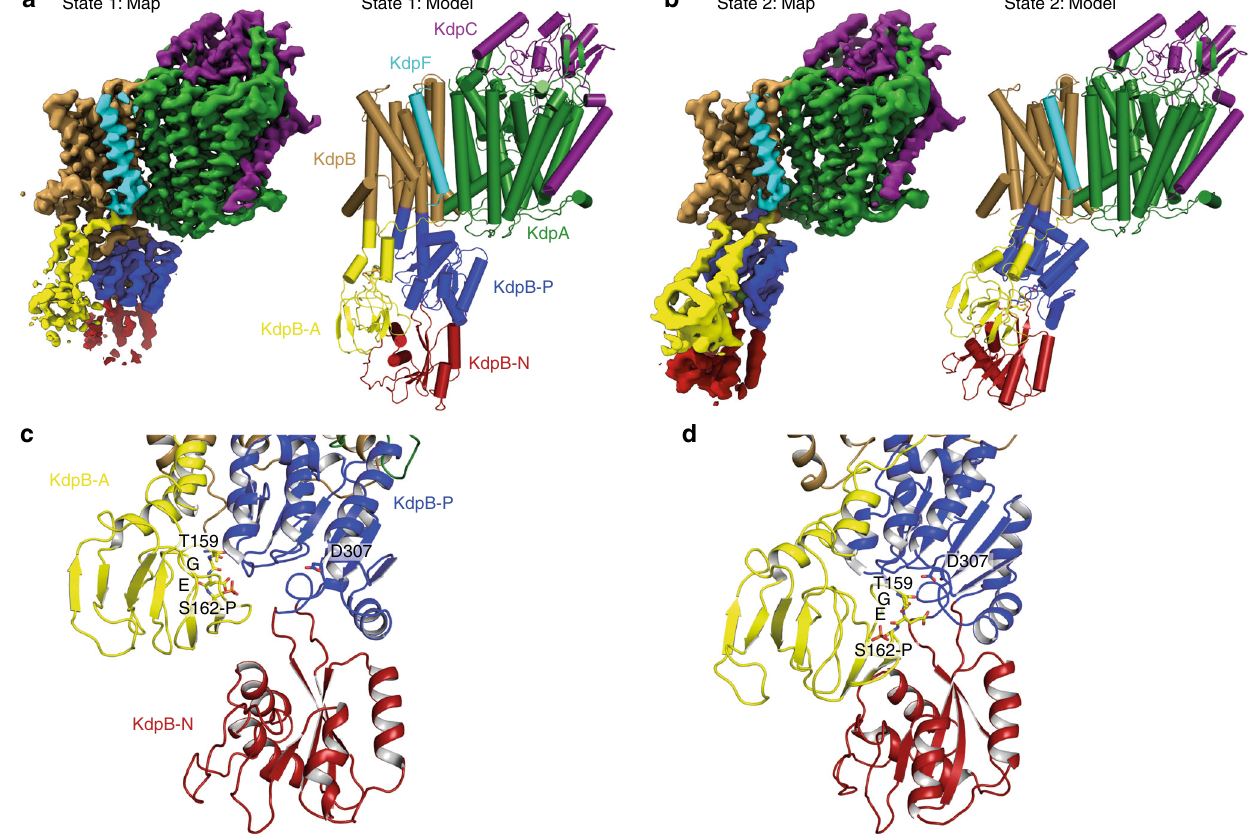
Fig. 1 Overview of KdpFABC cryo-EM structures in different conformations. a , b Overall view of cryo-EM maps and models of the KdpFABC complex in states 1 ( a ) and 2 ( b ), models are shown in cylindrical presentation. c , d Close-up view of the N, P, and A cytoplasmic domains of KdpB in state 1 ( c ) and state 2 ( d ). Highlighted are the TGES motif, including phosphorylation at Ser162, and the catalytic phosphorylation site Asp307. Color code throughout the manuscript, unless stated otherwise, is as follows: KdpC in purple, KdpA in green, KdpF in cyan, KdpB in sand with P domain in blue, N domain in red and A domain in